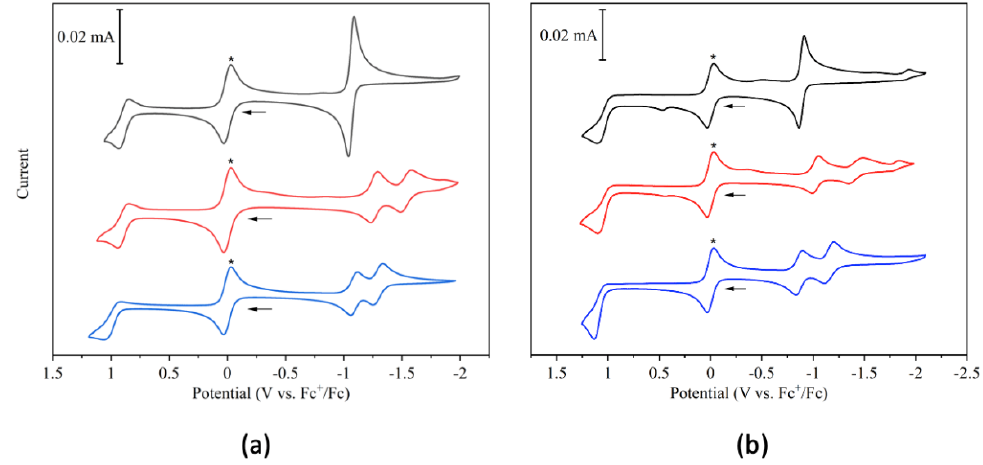
Figure 6. Cyclic voltammograms at 100 mV/s on platinum electrodes of 1 mM solutions of ( a ) 2catPy (blue), 3catPy (red), and 4catPy (black) and ( b ) 2catPyCl 2 (blue), 3catPyCl 2 (red), and 4catPyCl 2 (black), in degassed, anhydrous acetonitrile with 0.25 M NBu 4 PF 6 supporting electrolyte. Arrows indicate the direction of the potential scan. The wave marked with an asterisk (*) at 0 V vs. Fc + /Fc corresponds to the internal Fc standard. Table 3. Oxidation and reduction potentials for BODIPYs determined by cyclic voltammetry (in V vs. Fc + /Fc) at 100 mV/s in degassed and anhydrous acetonitrile with 0.25 M NBu 4 PF 6 at analyte concentrations of 0.001 M.